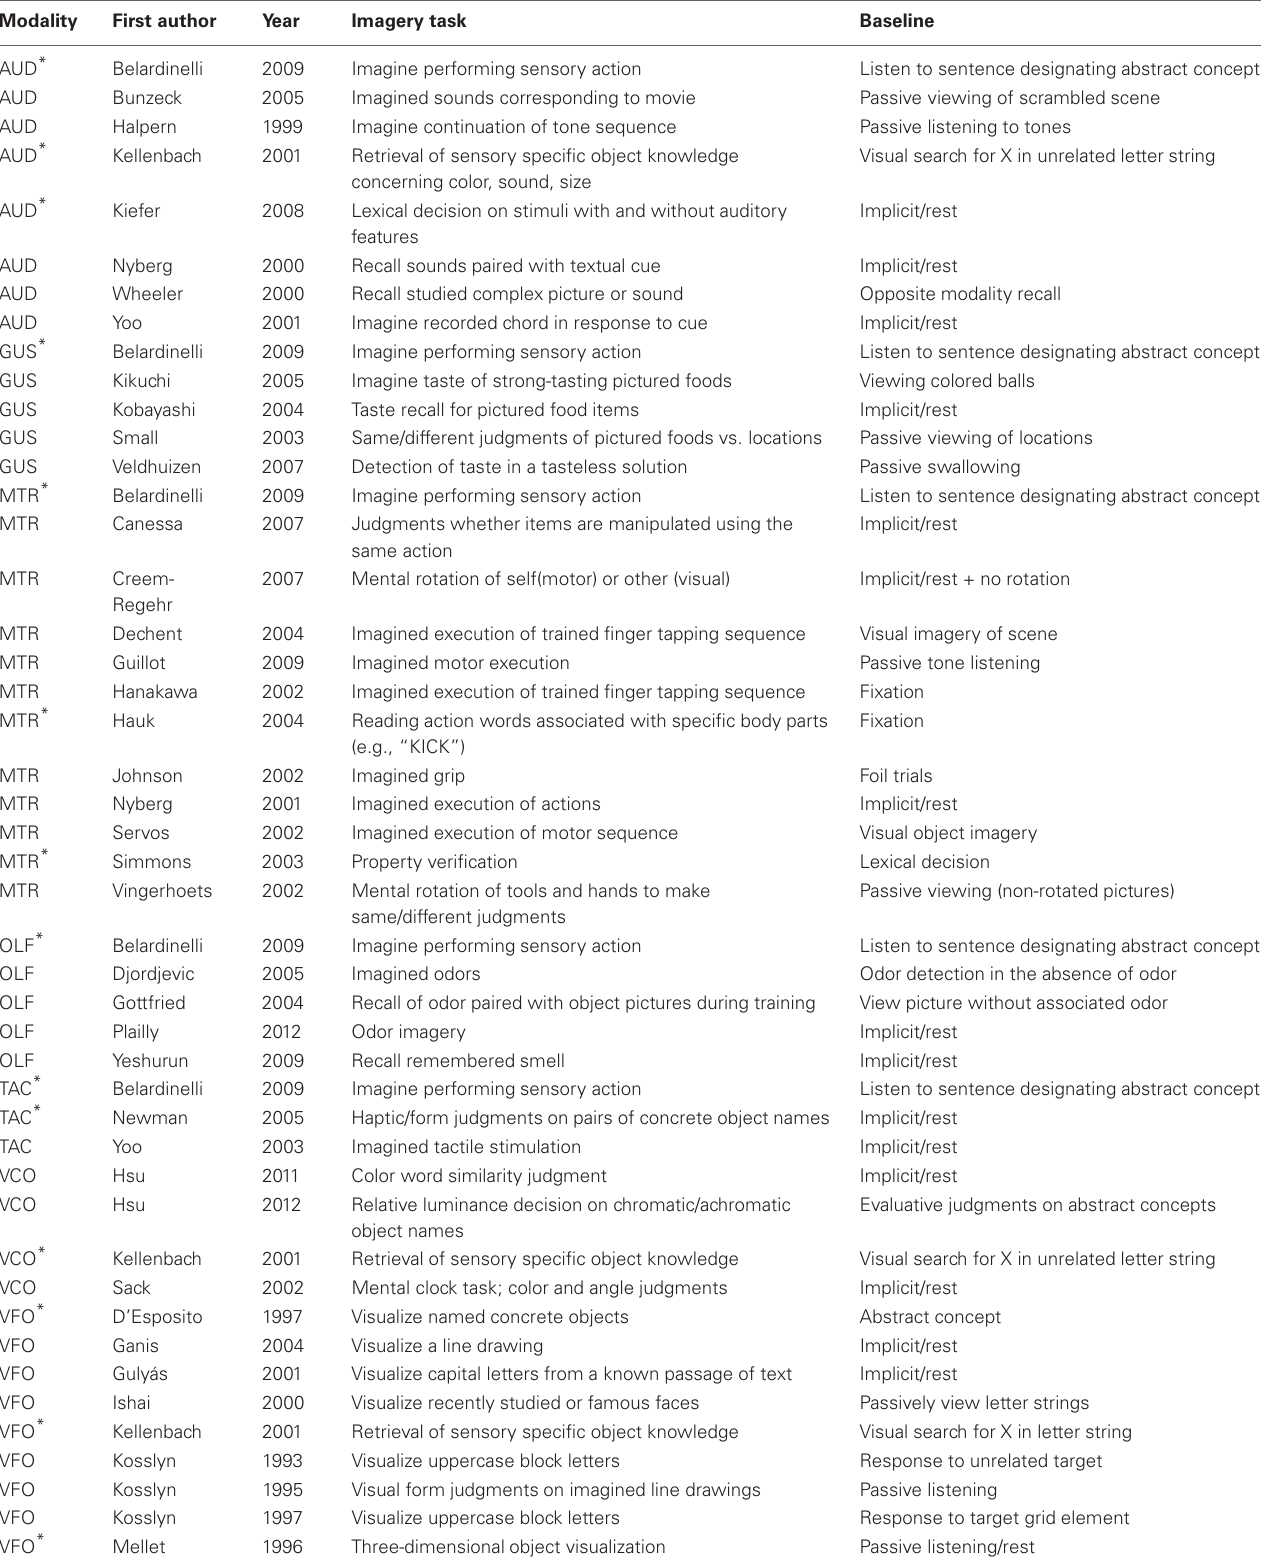
Table 1 | Studies used in the imagery